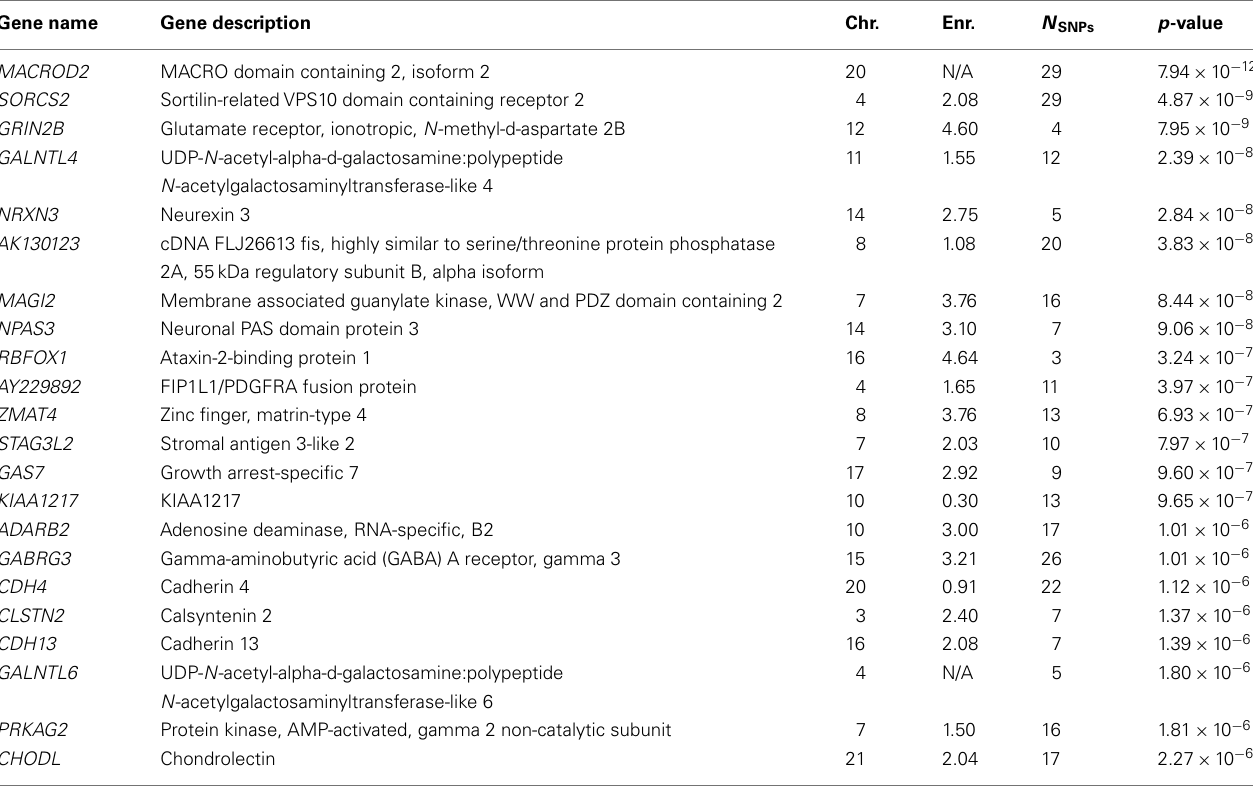
Table 1 | Genes showing significant associations with an MRI-derived measure of temporal lobe